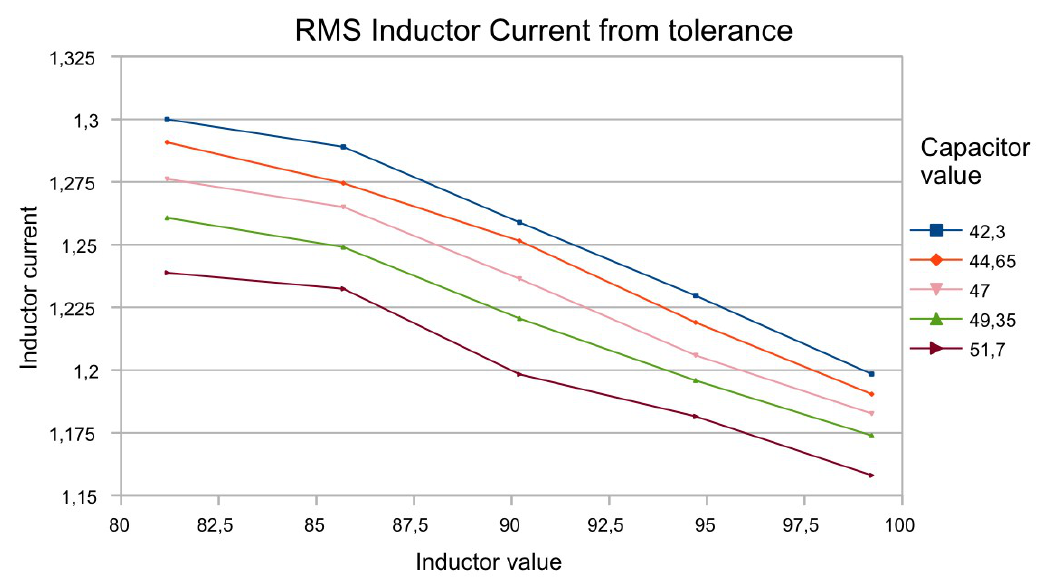
Figure 14. Tolerance analysis of the resonant current with optimized values.